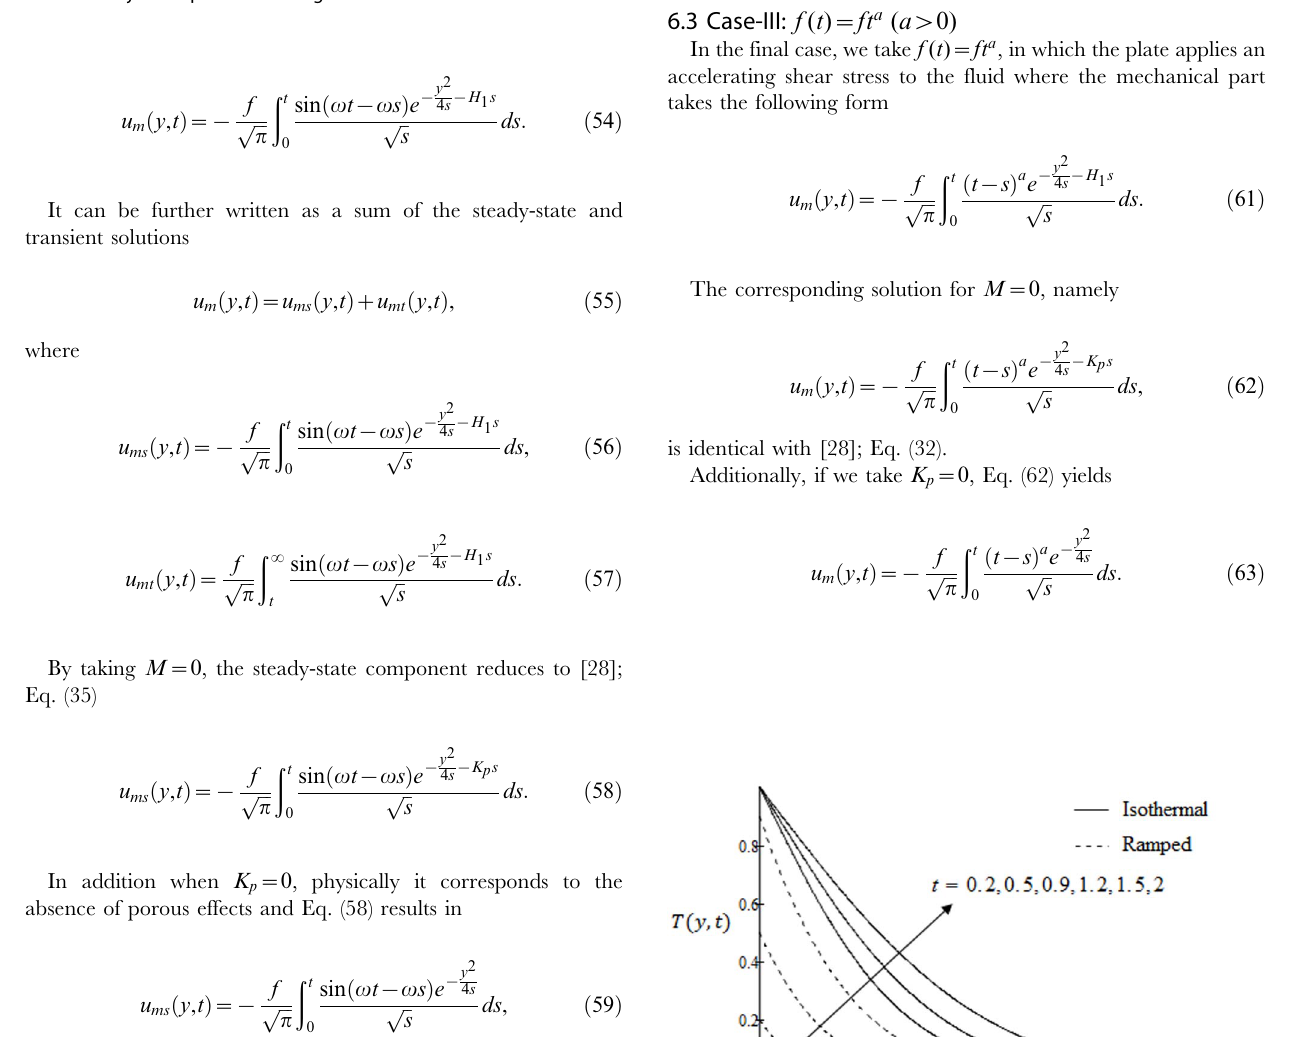
Figure 9. Velocity profiles for different values of Pr eff when the plate applies a constant shear stress f ~{ 0 : 25 .